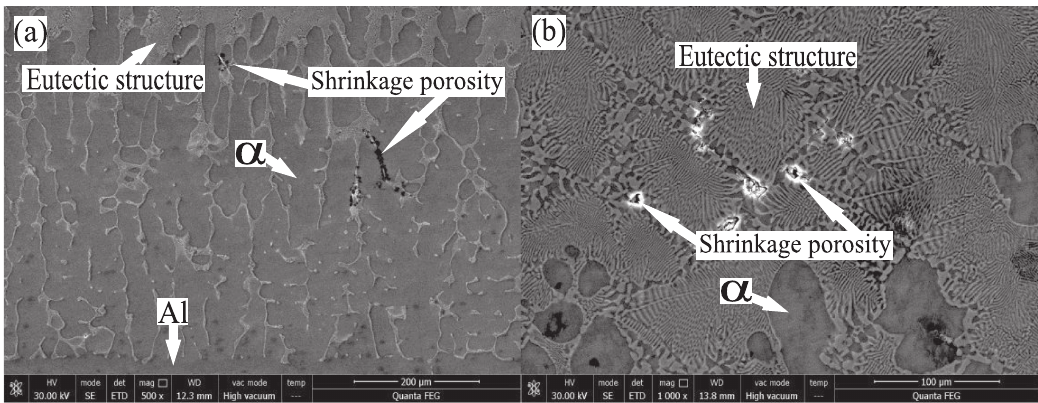
Figure 6: Shrinkage porosities within the transition